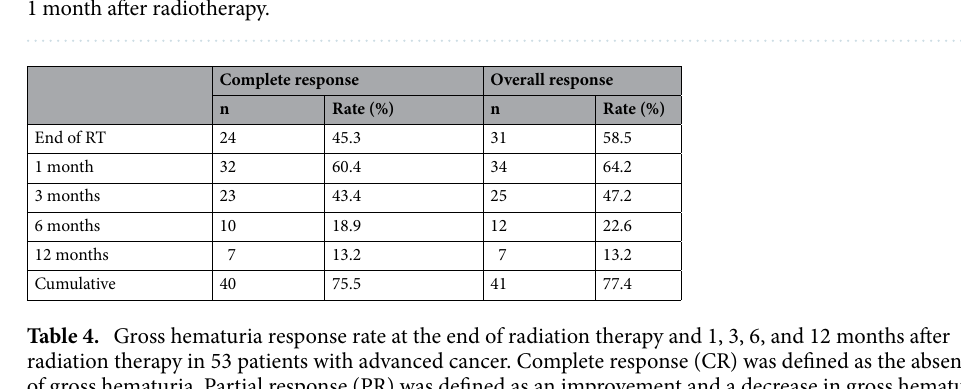
Figure 1. ( a ) Overall survival, ( b ) hematuria control duration, ( c ) blood transfusion-free duration in patients who required blood transfusion within 3 months before radiotherapy, and ( d ) blood transfusion-free duration 1 month after radiotherapy.